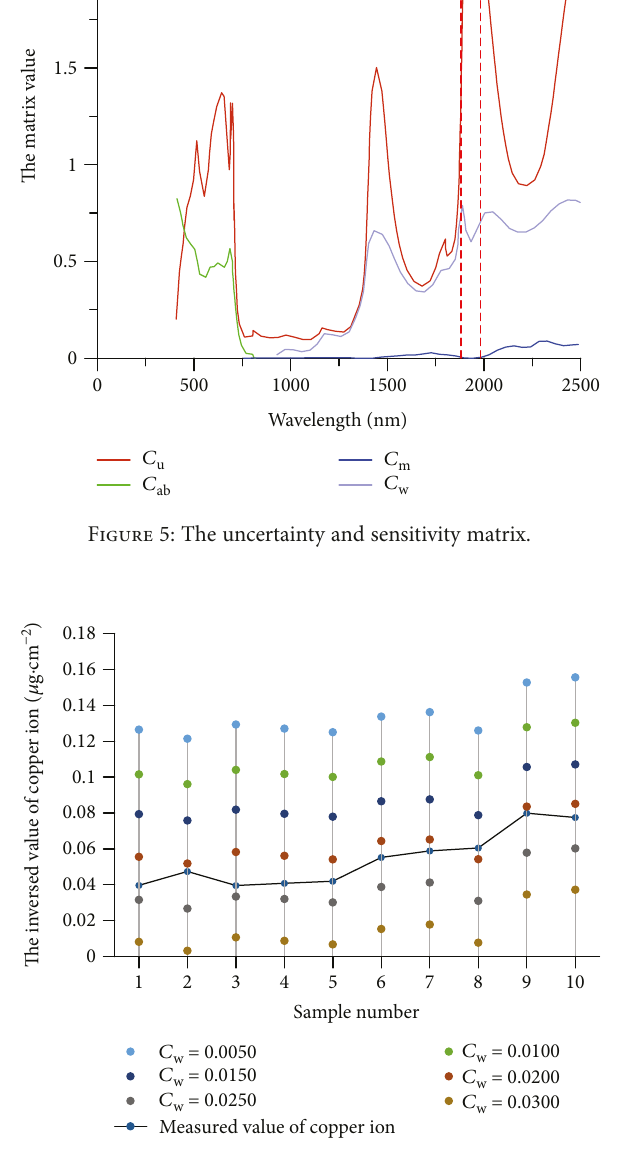
Figure 6: The inverted copper ion content under 6 water content levels. The true value of copper ion is indicated with line- connected dots. The horizontal and vertical axes represent the sample number and the copper ion content, respectively.